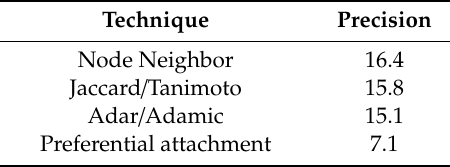
Table 6. Precision of various metrics